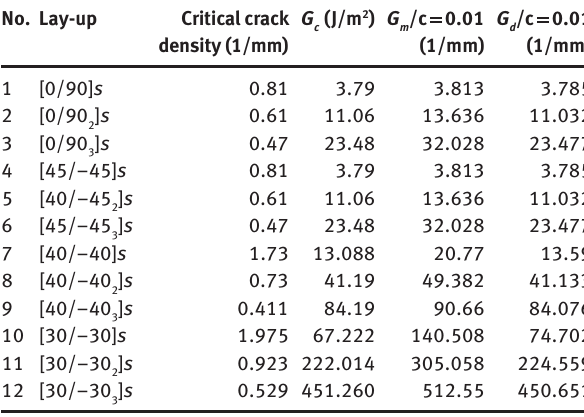
Figure 20: Crack density vs. energy release rate for [30/−30 epoxy laminate for under σ